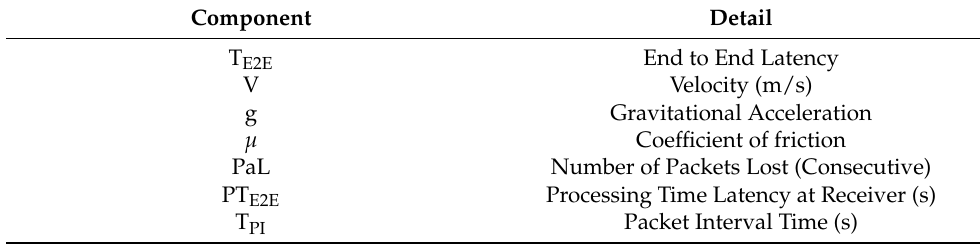
Table 4. Parameter